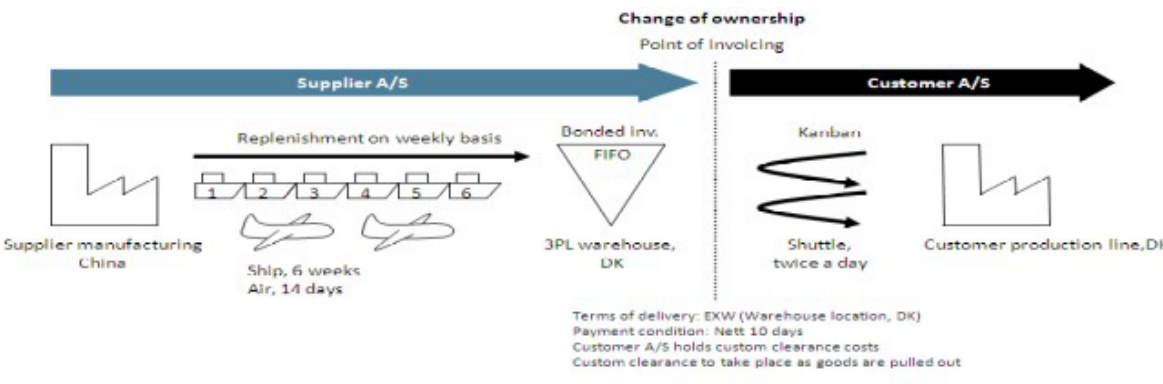
Figure 2. The supply chain setup after the VMI